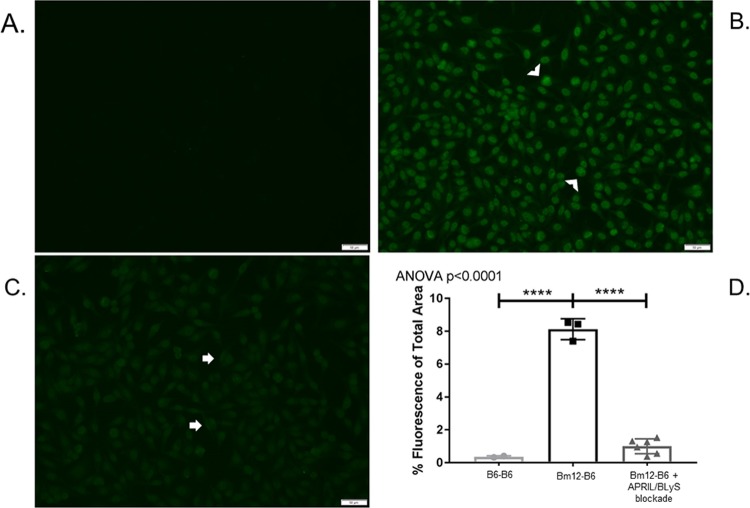
APRIL/BLyS blockade resulted in significant reduction of anti-nuclear autoantibodies (ANA).Representative images from indirect immunofluorescence assay detecting circulating anti-nuclear autoantibodies (ANA). (A) B6-B6 transplant group, (B) Bm12-B6 transplant group with no treatment. Arrowheads indicate high-intensity staining. (C) Bm12-B6 transplant group treated with APRIL/BLyS blockade. Arrows indicate low-intensity staining. (D) Densitometry using FITC anti-IgG to detect ANA formation in serum. Graph depicts percentage of total area that was fluorescent. APRIL/BLyS blockade resulted in a significant decrease of total fluorescence indicating a significant decrease in circulating ANA.